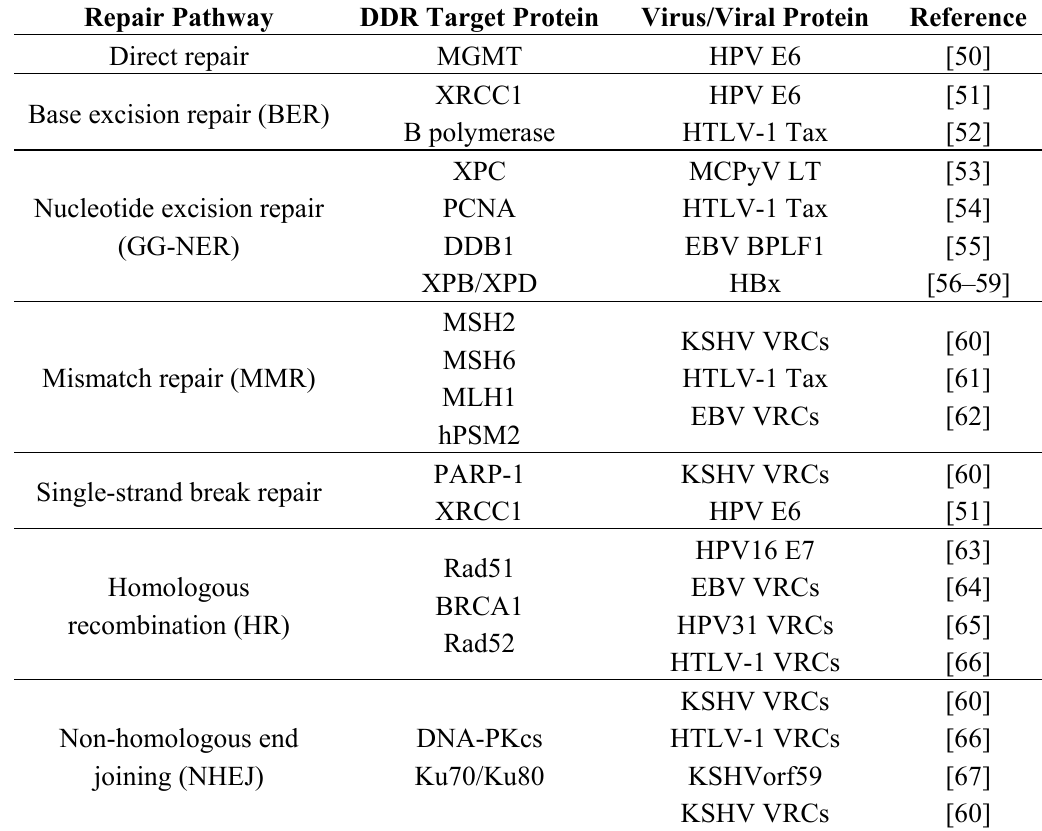
Table 2. Viral interactions with components of core DNA repair pathways. This list is not exhaustive but includes observations mentioned in this article. VRCs—Viral replication